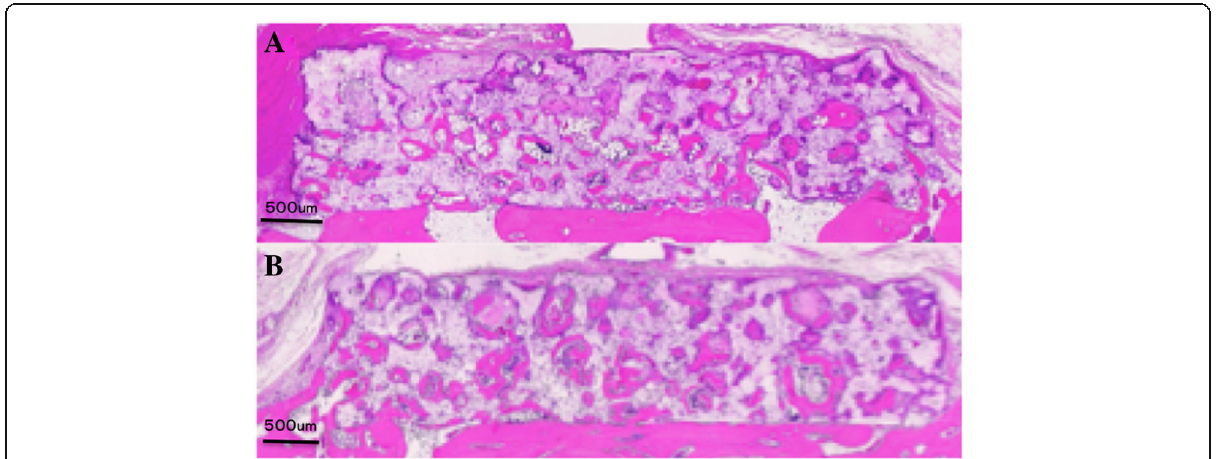
Fig. 3 Histological. a u-HA/PDLLA + types 1 and 3 collagen. b